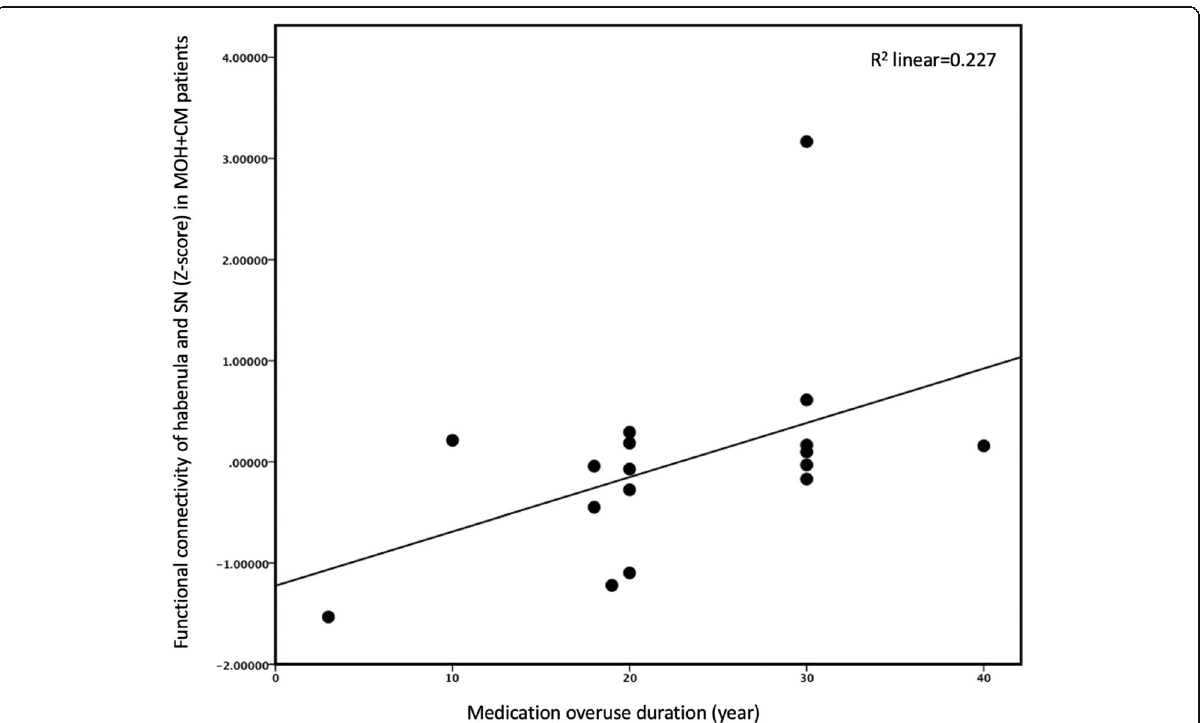
Fig. 4 Correlation analysis between functional connectivity of habenula and SN and medication overuse duration. Correlation analysis results of the functional connectivity between habenula and SN and medication overuse duration. The relationship between these resting-state abnormalities and the other clinical variables were also checked. No results exceeded the threshold. SN, salience network